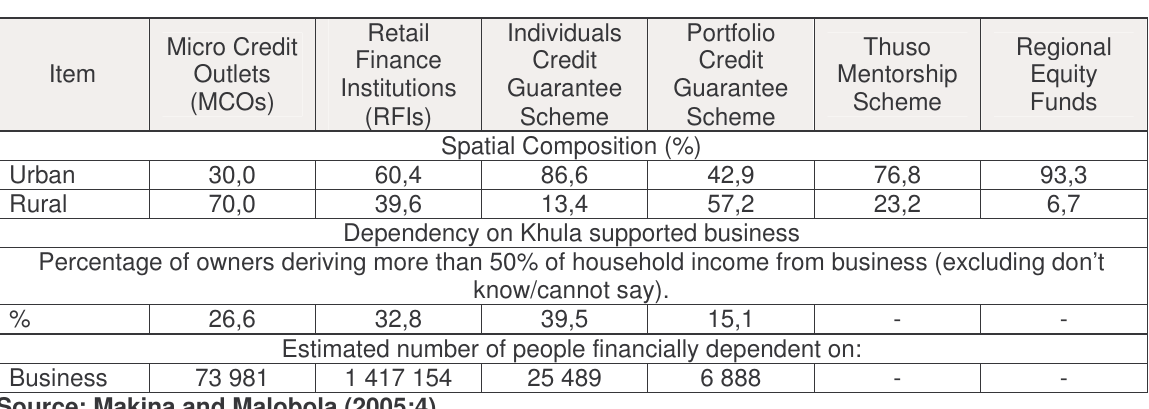
Table 3: Rural versus urban breakdown and household support - 1996 to